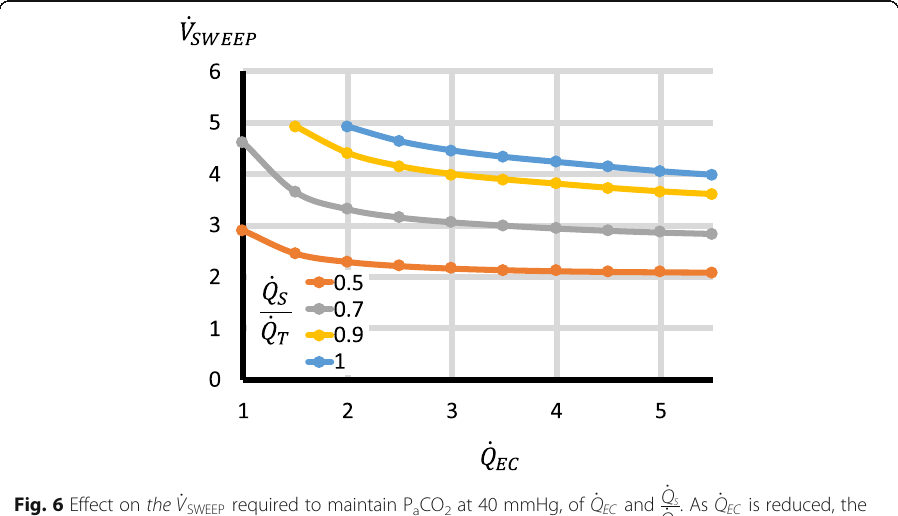
Fig. 6 Effect on the _ V SWEEP required to maintain P a CO 2 at 40 mmHg, of _ Q EC and required _ V SWEEP rises, though the rise is small until _ Q EC is < 2 l/min. The required _ V SWEEP rises as